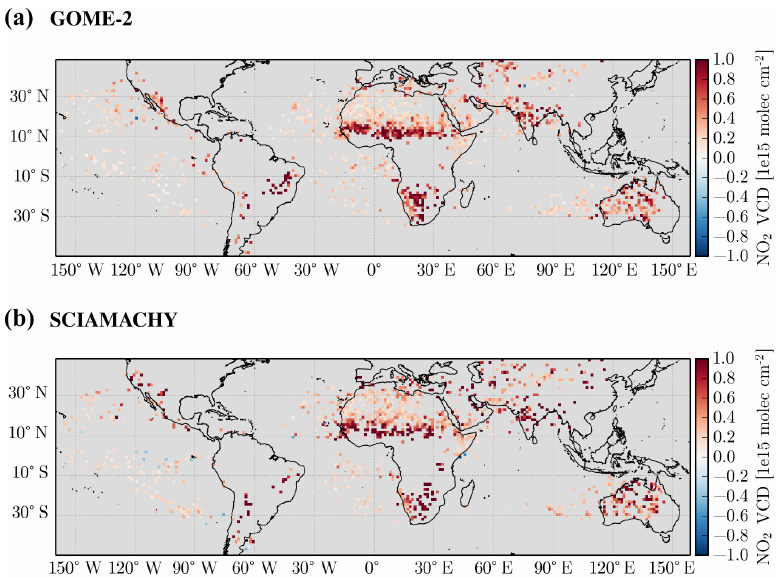
Figure D1. In this figure, absolute differences in NO 2 VCDs compared to Days − 10 to − 2 from GOME-2 (a) and SCIAMACHY (b) on Day0 (first day of rainfall) are depicted, which were computed similarly as for OMI in Fig. 3d for OMI. The data were screened for significant changes and pixels containing less than 20 measurements on Day0 (or less then 50 measurements from Day − 10 to Day −